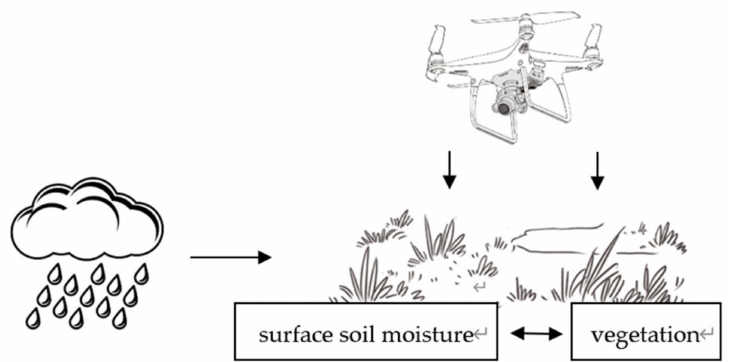
Figure 1. Schematic diagram of